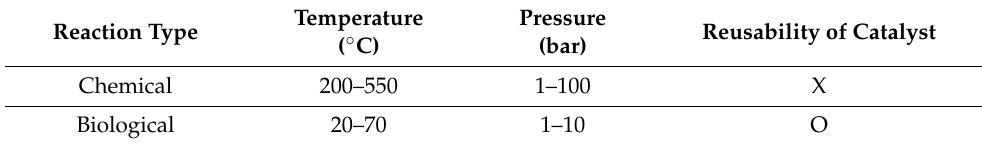
Table 2. Comparison of chemical and biological reactions [32–34].